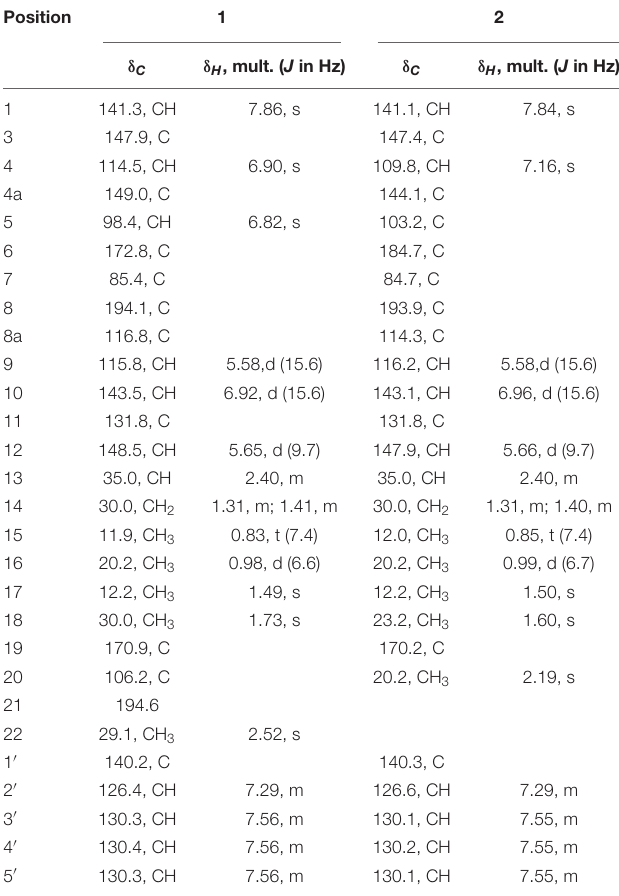
TABLE 1 | 1 H NMR and 13 C NMR data of compounds 1 and 2 in CDCl 3